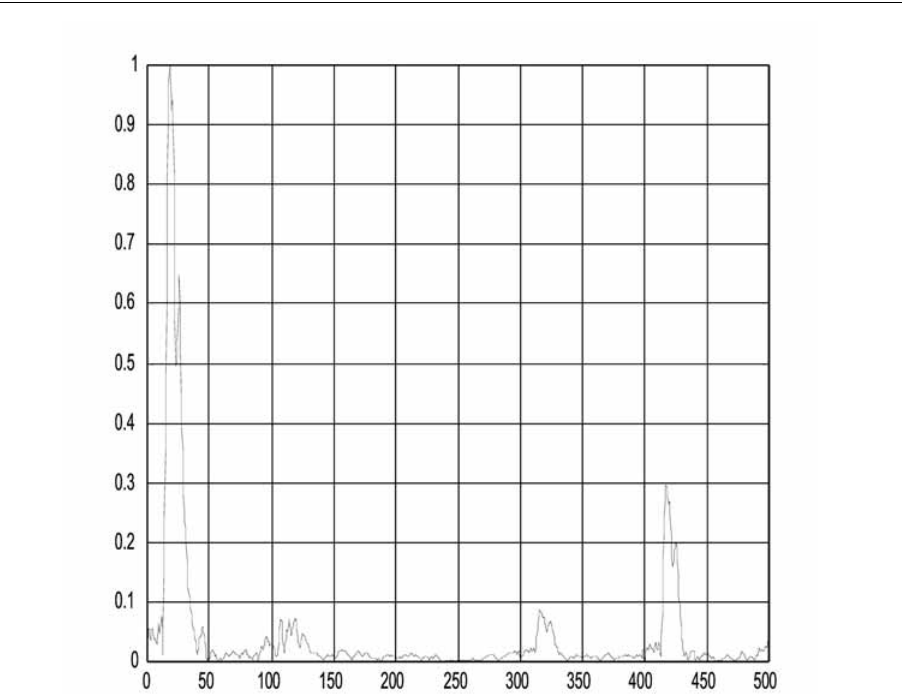
Fig. 14. One of the received synthetic time responses gathered in the laboratory of CO.RI.S.T.A. The function is normalised and expressed as a function of time in